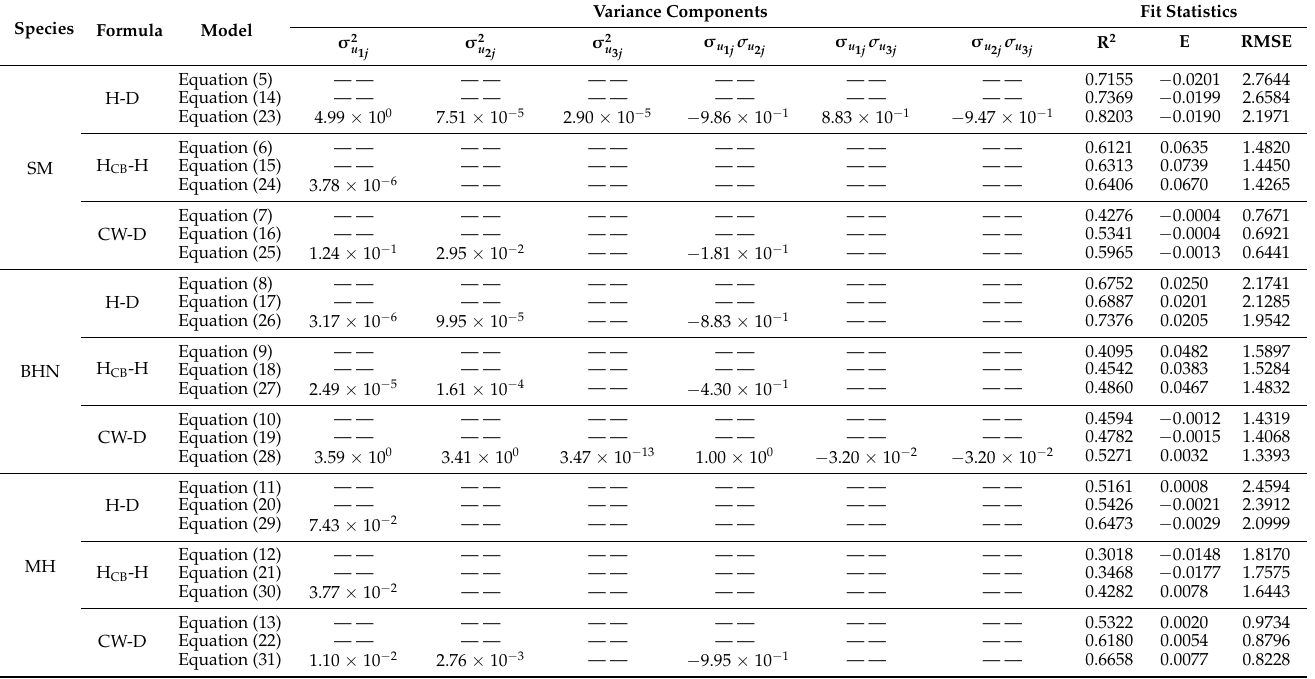
Table 5. Parameter estimates and evaluation indices of each model. SM, BHN, and MH represent Cunninghamia lanceolata , Machilus pauhoi , and Schima superba , respectively; u 1 j , u 2 j , u 3 j are the random effect parameters caused by the jth sample plot on β 1, β 2, β 3 ,